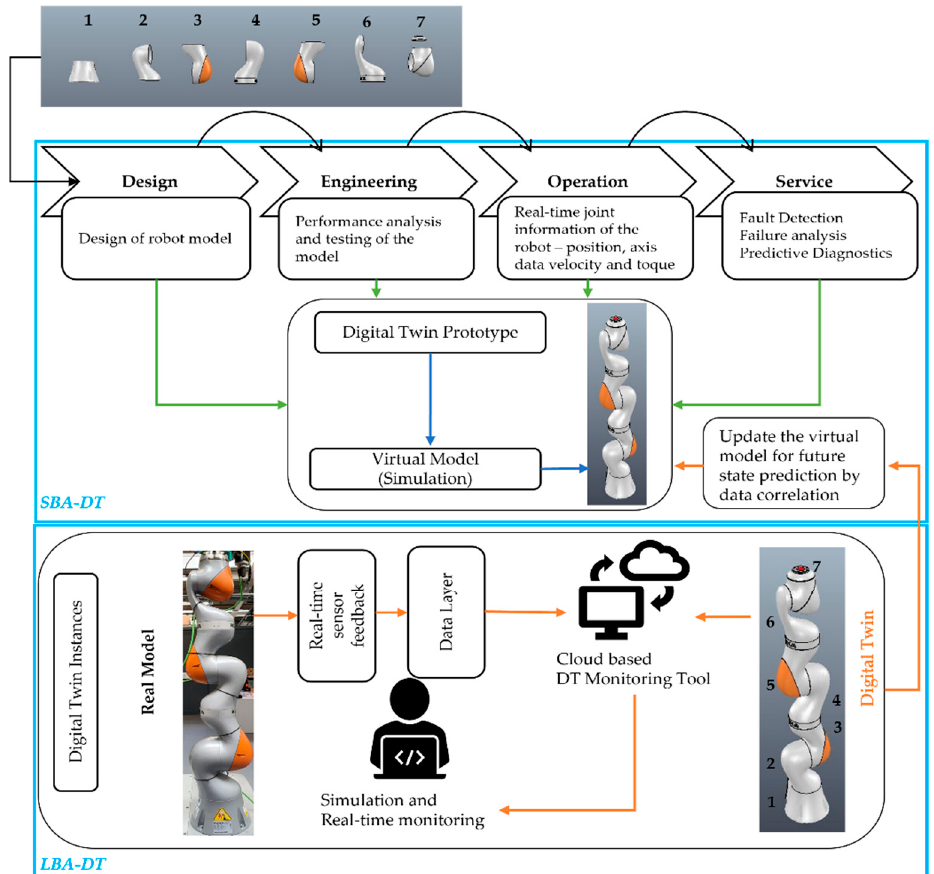
Figure 7. Conceptual SBA and LBA for DT of the collaborative robotic arm. The developed DT can be a part of the digital factory environment.